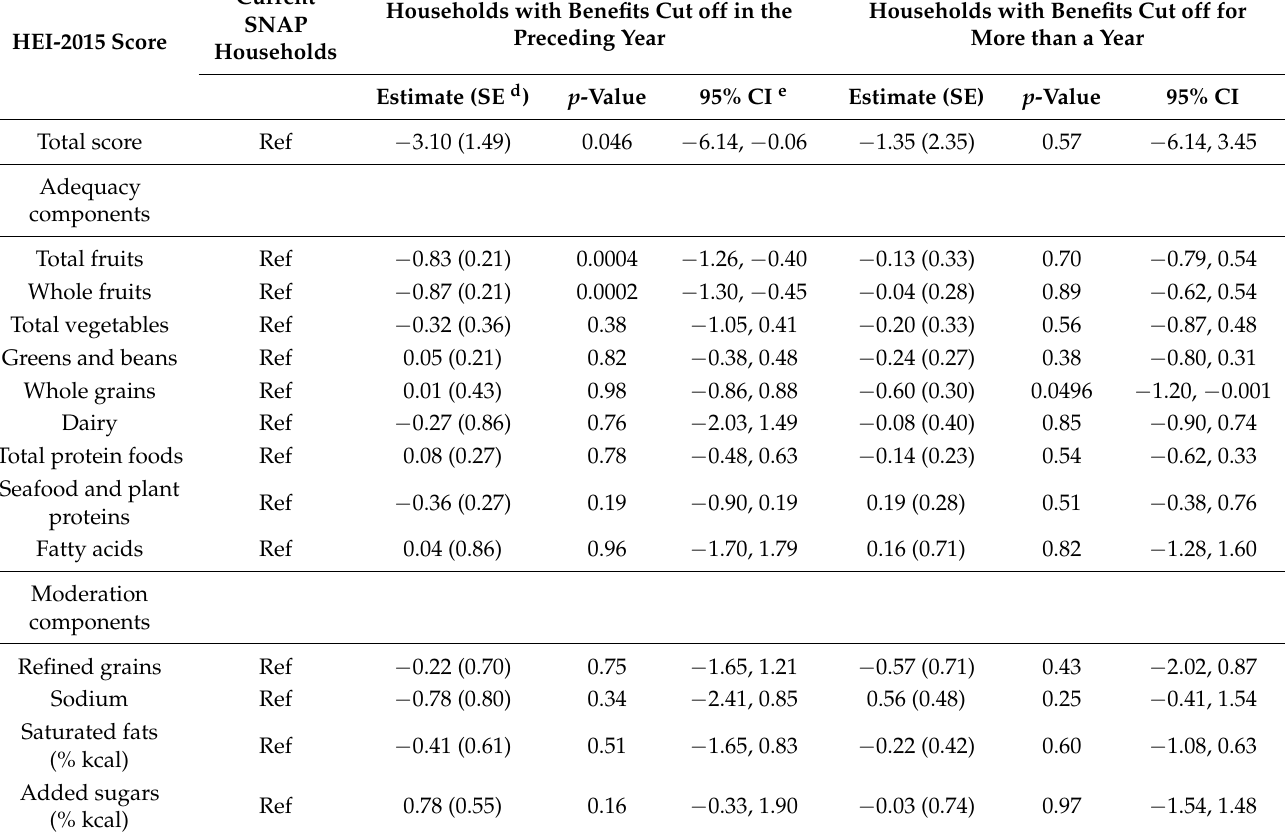
Table 3. Association a of SNAP b participation status with HEI c -2015 total and component scores of food-at-home acquisitions among income-eligible households in the National Household Food Acquisition and Purchase Survey 2012– 2013 ( n =